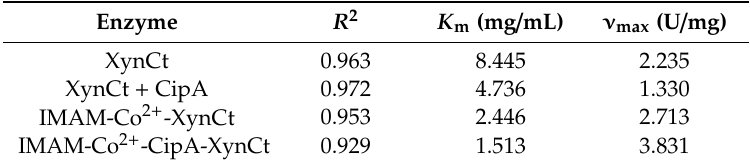
Table 2. Other reagents were of analytical grade and obtained from local